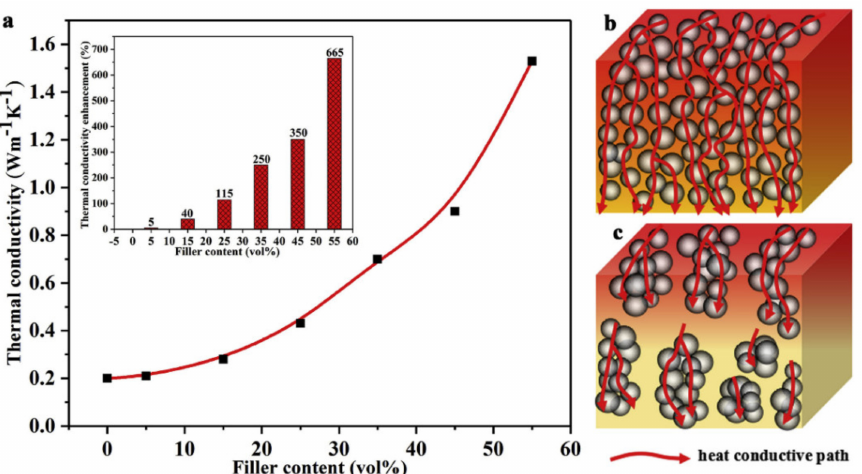
Figure 8. ( a ) Thermal conductivity of the SR composites filled with different contents of Al 2 O 3 nanospheres and heat flow models of composites with good dispersion ( b ) and poor dispersion ( c ) [154]. Copyright©2020 Elsevier Ltd. All rights